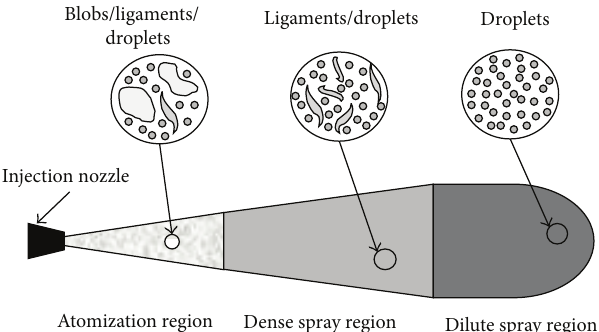
Table 3: Characteristics of the considered HFO and